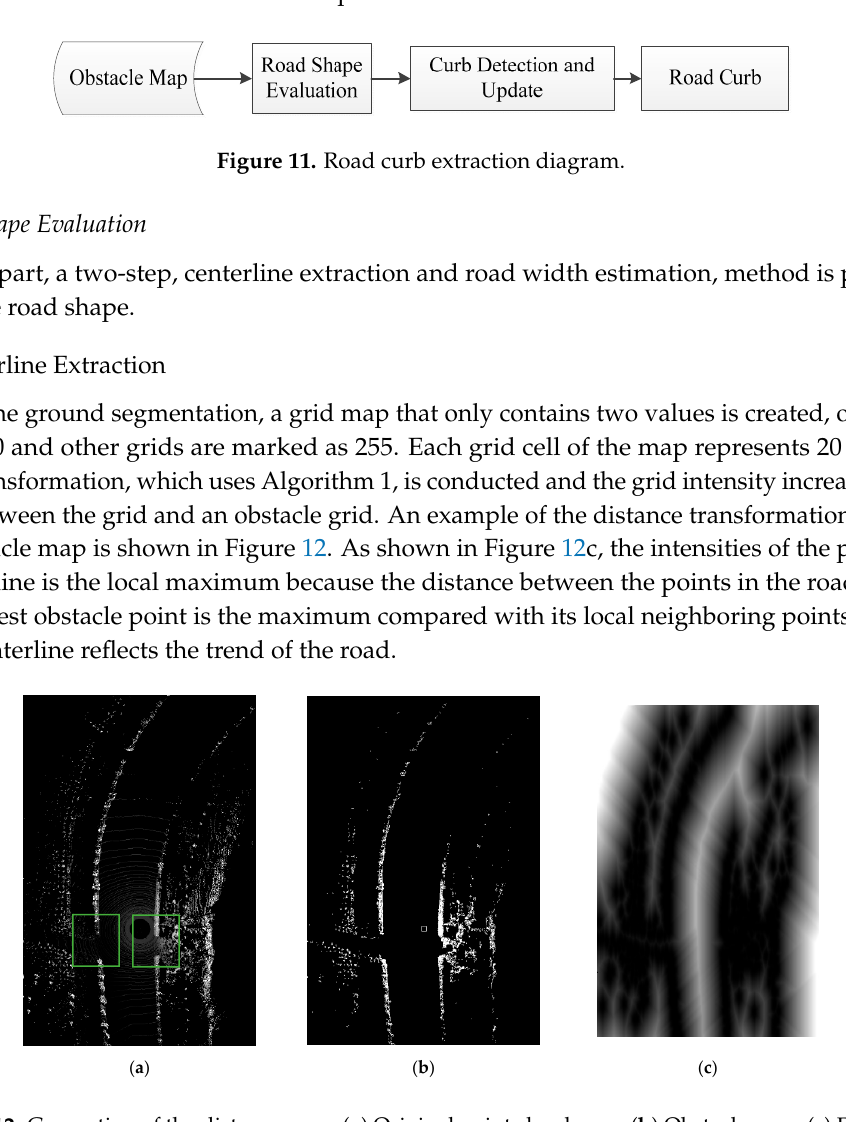
Figure 12. Generation of the distance map. ( a ) Original point cloud map; ( b ) Obstacle map; ( c ) Distance intensity map.